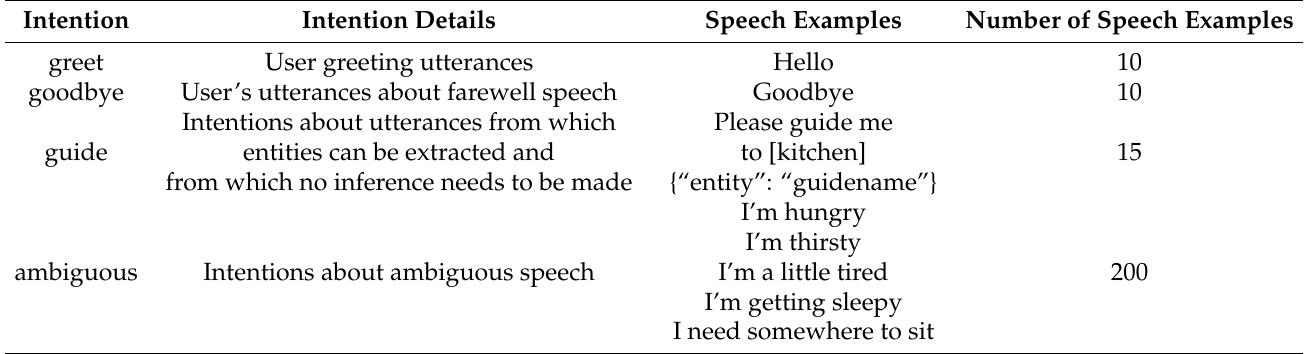
Figure 6. Example dataset description of the natural language module for greeting intentions. Table 1. List of Natural Language Module Data Set